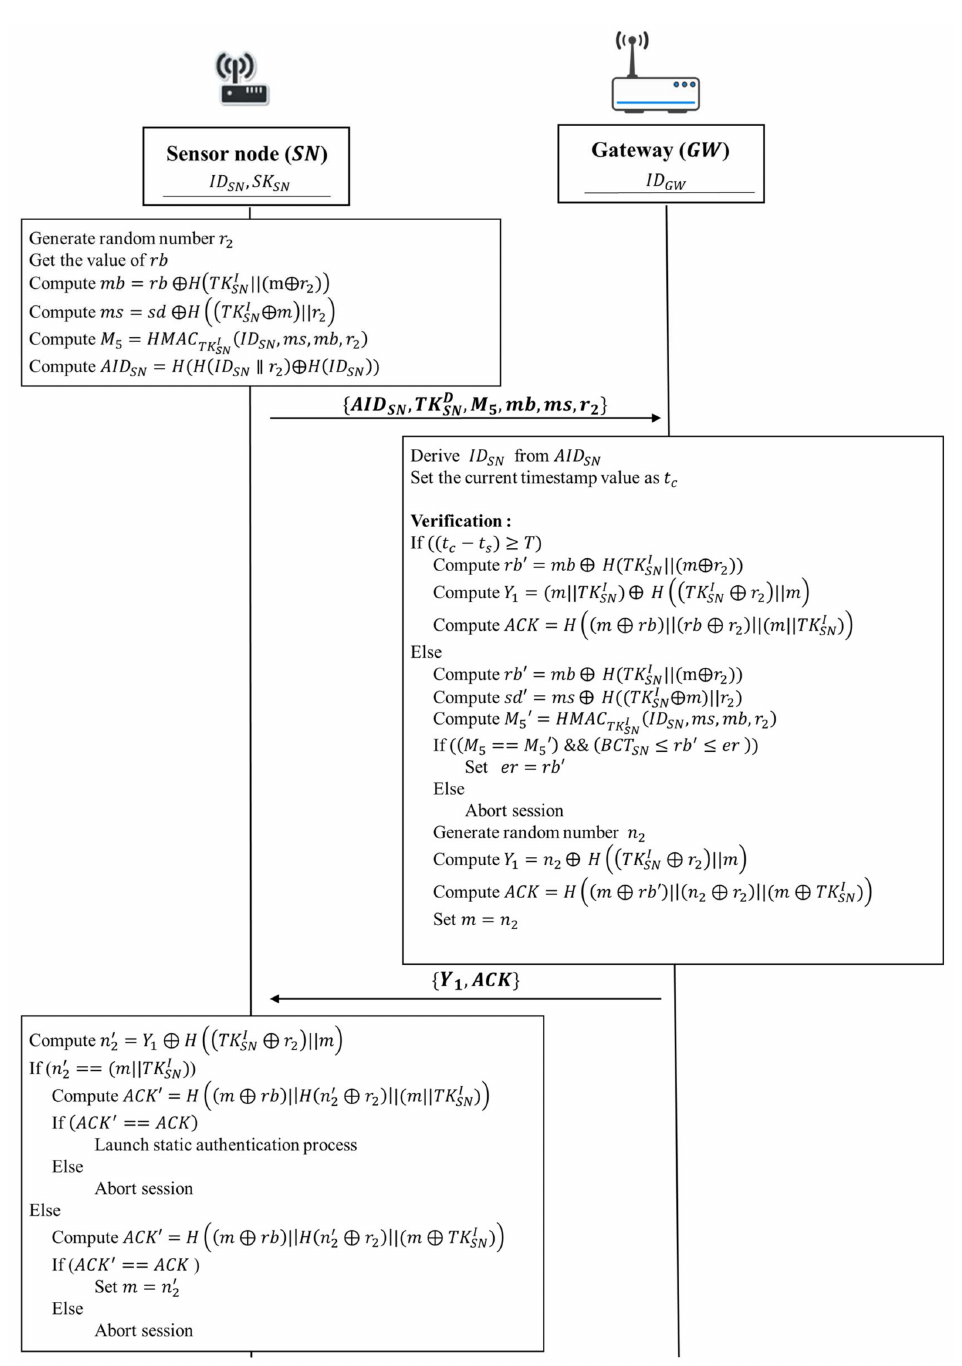
Figure 14. The continuous authentication phase with identity